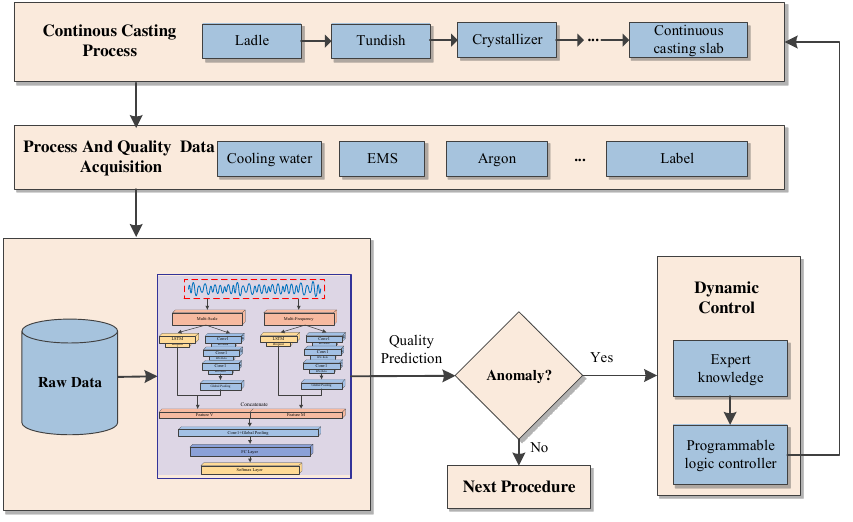
Figure 5. The framework of quality prediction system based on